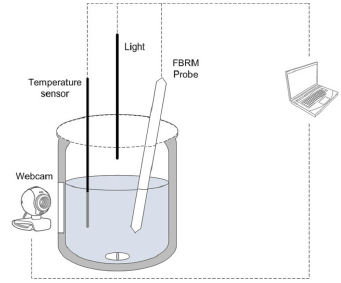
Figure 1. Schematic of the apparatus used to perform the experiments.